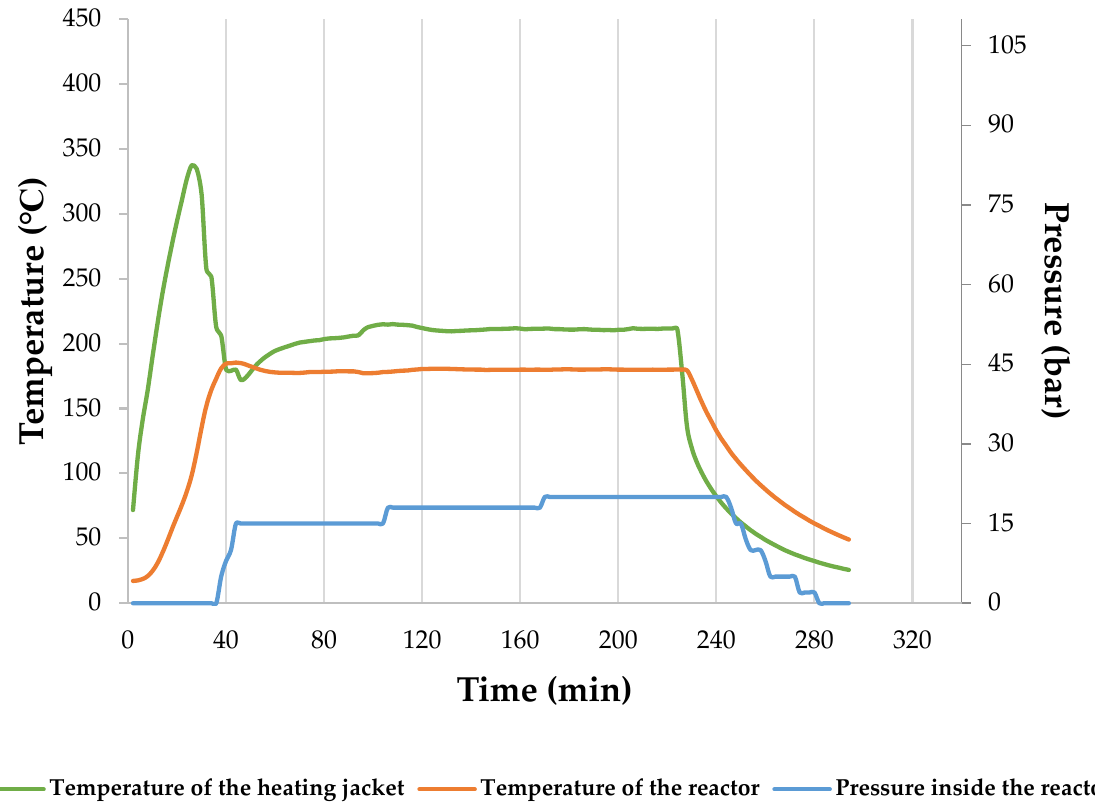
Figure A3. Temperature and pressure patterns during the process at 180 ◦ C in 180 min.